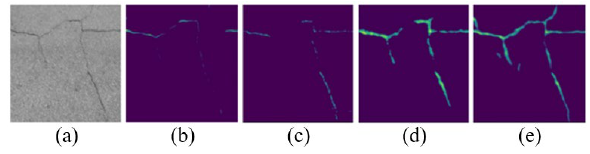
Table 1. The dimensions of each layer in the encoder.